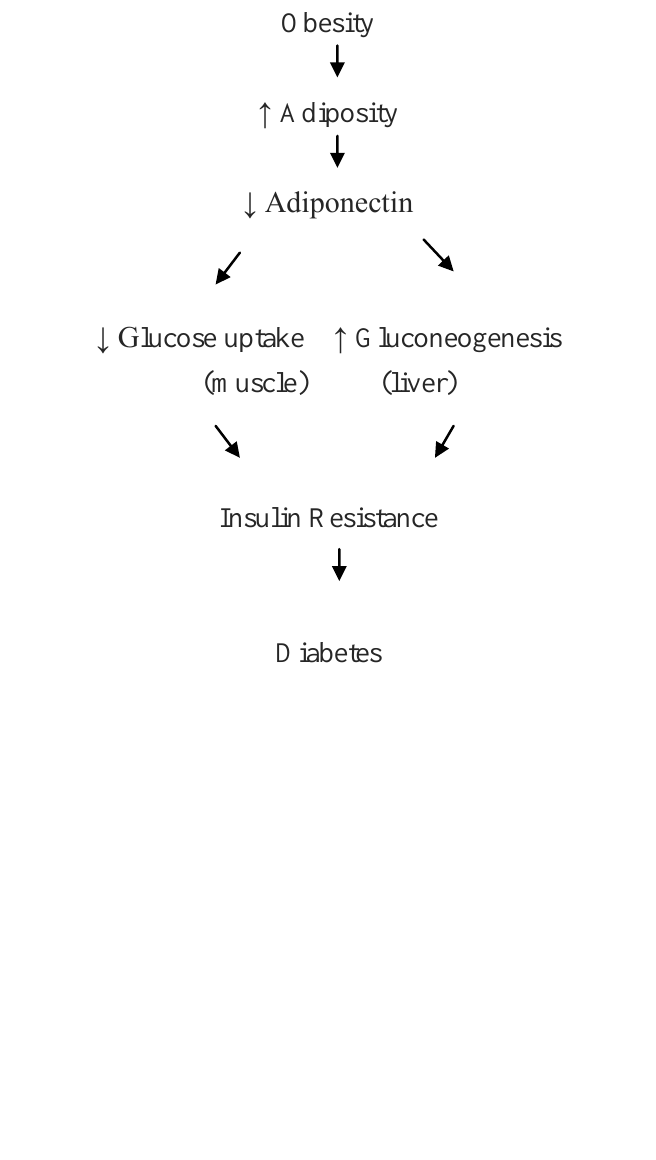
Figure 1. Proposed link among adiposity, adiponectin, insulin resistance and